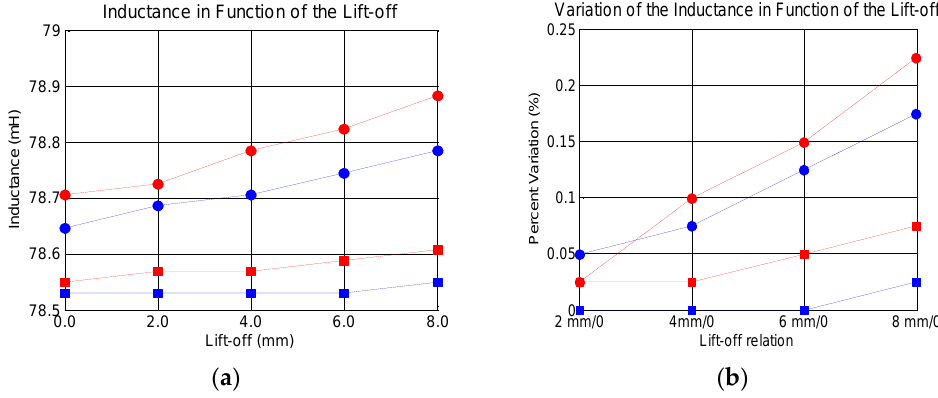
Figure 19. Lift-off effects on the inductance values. ( a ) absolute values; ( b ) Percent variation.